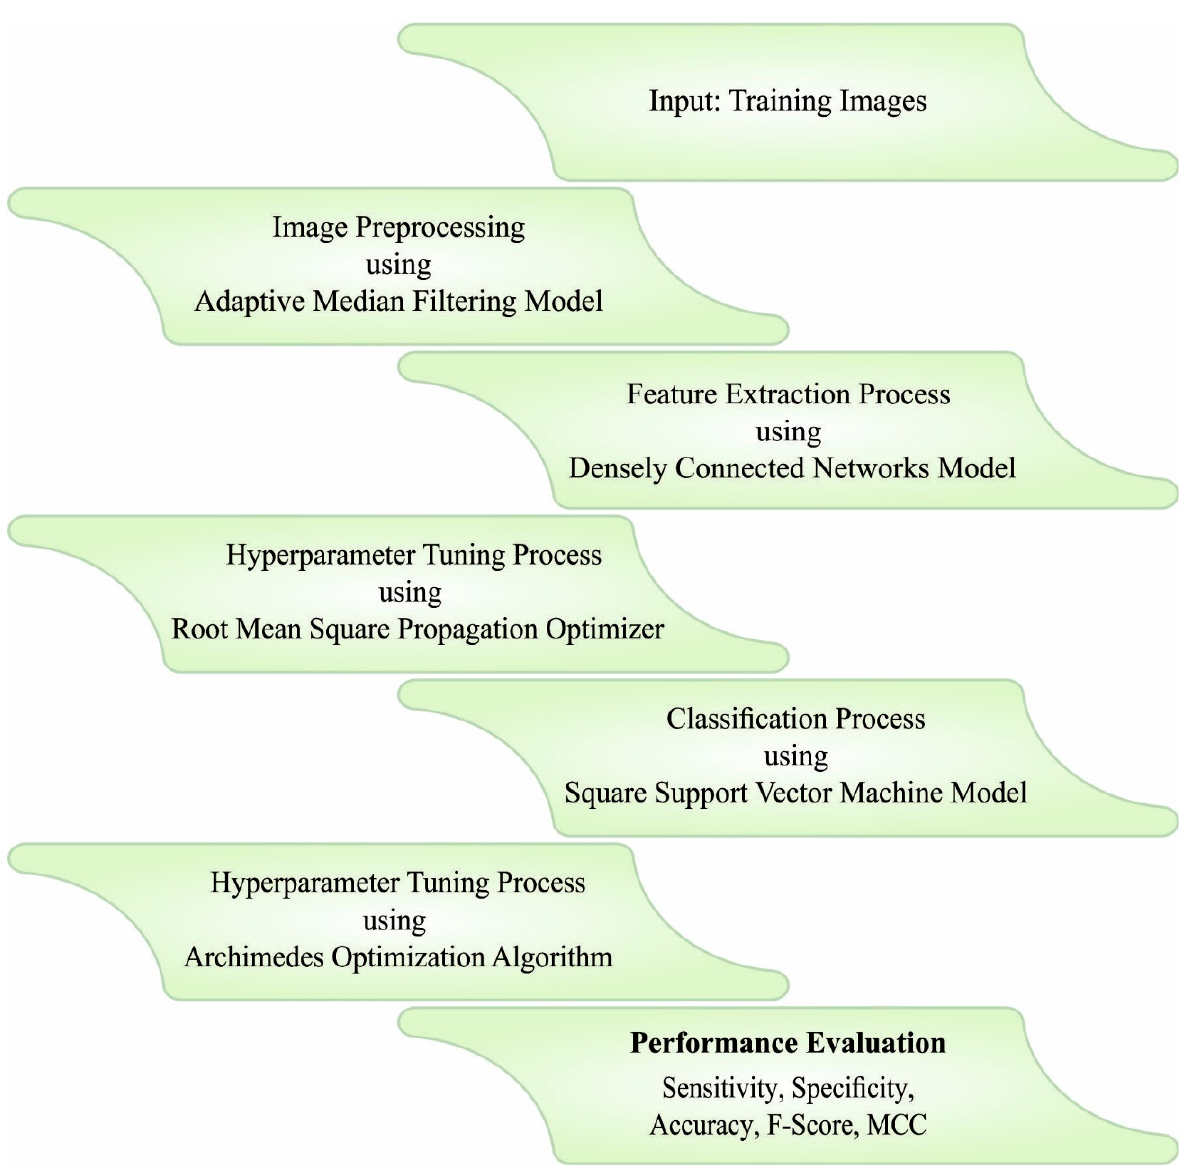
Figure 1. Overall working process of the AOADLB-P2C system.